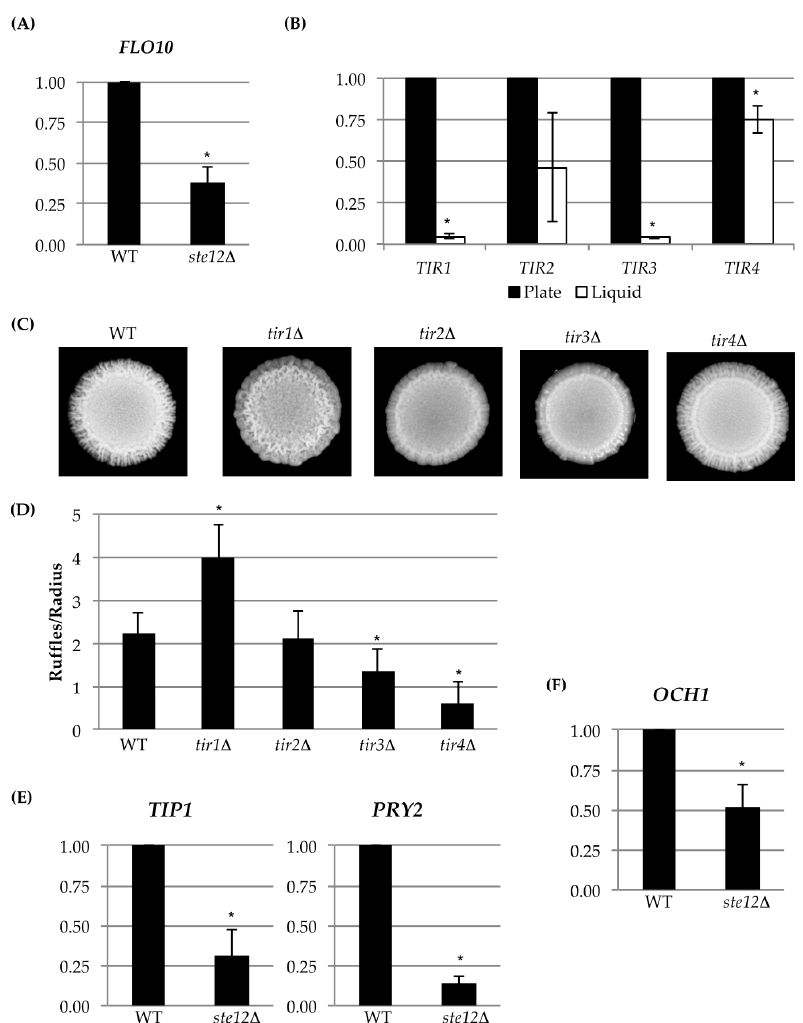
Figure 3. Analysis of cell-wall gene expression and mutant phenotypes. qPCR analysis was used to measure differences in expression levels of targets of identified by MASS SPEC analysis and gene expression profiling. ( A ) FLO10 ; ( B ) TIR gene family expression analysis from cells grown on agar media versus liquid. All asterisks are p < 0.05 for each pair; ( C ) colonies of wild-type (WT, PC538) cells and the indicated deletion mutants of members of the TIR family; ( D ) bar graph showing number of ruffles per radii in the wild type and the indicated TIR deletion mutants (strain numbers of TIR deletion mutants can be found in Table 1). Asterisks are p < 0.05 relative to WT. Additional qPCR analysis of targets identified in a comparative RNAseq experiment (Chow et al., under review; GSE115657) ( E ) TIP1 and PRY2 ; ( F ) OCH1 (WT, PC538; ste12 Δ , PC1079). All asterisks are p < 0.05 relative to wild type.